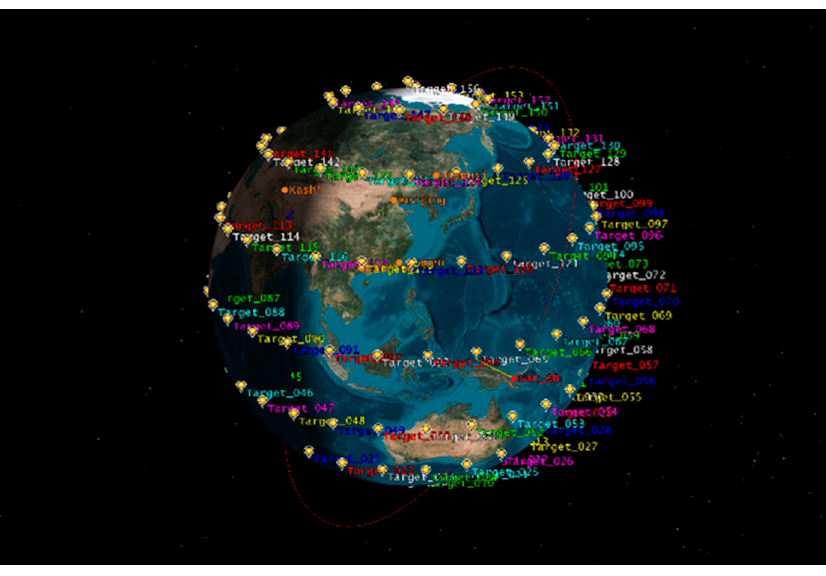
Figure 9. The task scenery.